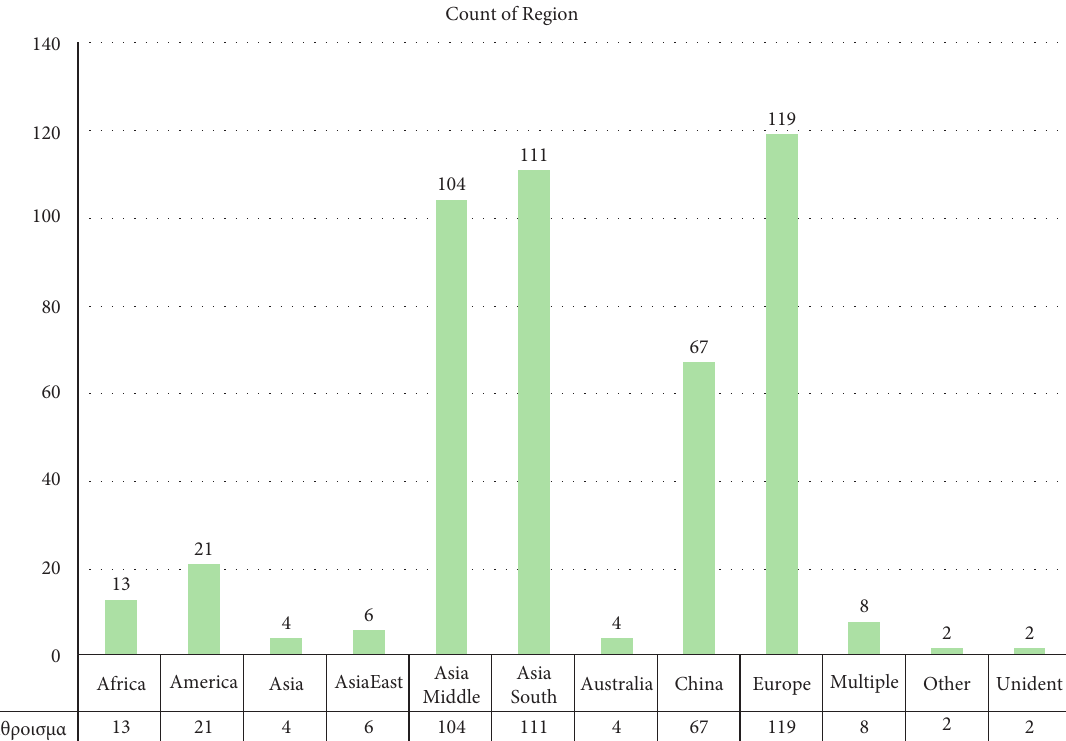
Figure 4: Count of